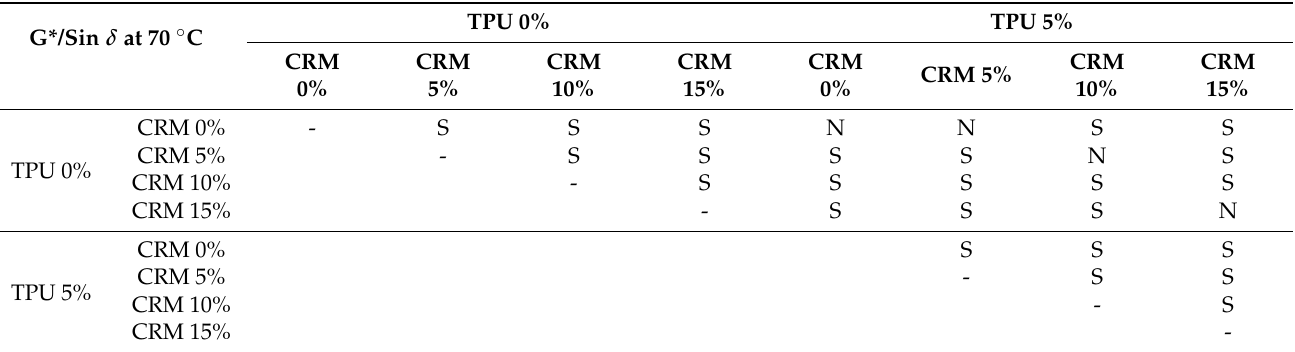
Table 6. Statistical analysis results of the RTFO G*/sin δ as a function of CRM contents and the addition of TPU ( α =